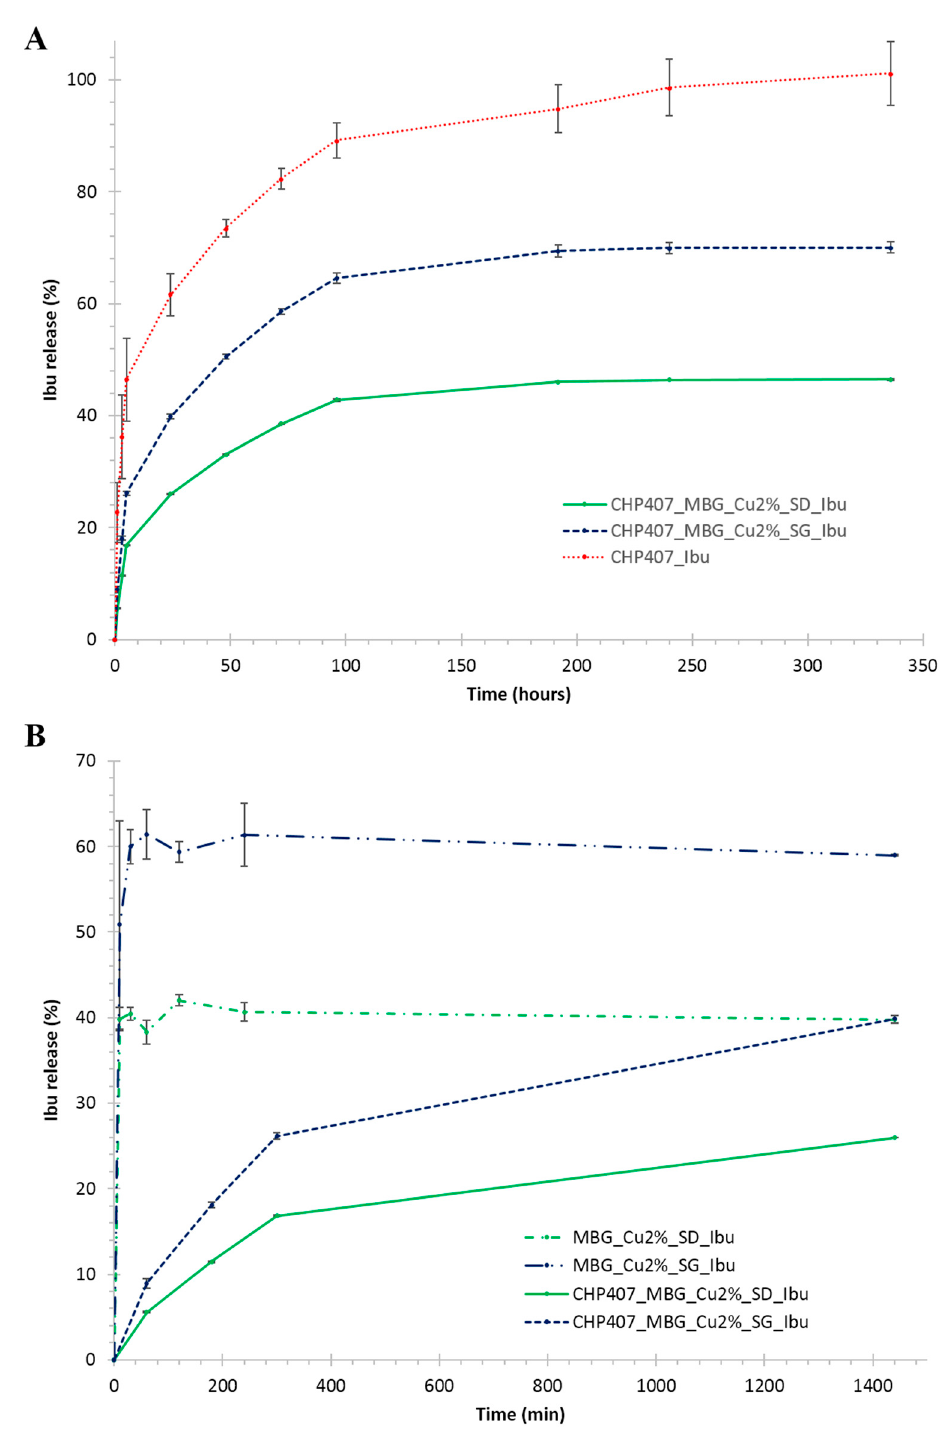
Figure 7. ( A ) Ibuprofen release (%) profile from CHP407_Ibu, CHP407_MBG_Cu2%_SG_Ibu and CHP407_MBG_Cu2%_SD_Ibu hydrogels. ( B ) Comparison among ibuprofen release profiles assessed from CHP407_MBG_Cu2%_SG_Ibu, CHP407_MBG_Cu2%_SD_Ibu, MBG_Cu2%_SD_Ibu and MBG_Cu2%_SD_Ibu. Figure 7A compares ibuprofen release profiles from CHP407_Ibu, CHP407_MBG_Cu2%_SG_Ibu and CHP407_MBG_Cu2%_SD_Ibu up to 14 days observation time.